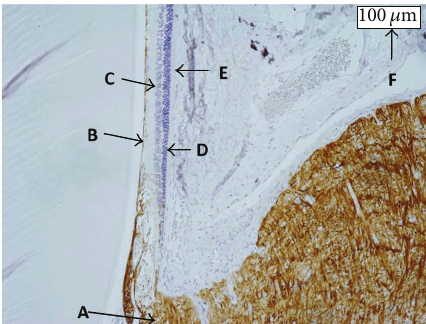
Figure 4: The retina in a normal SD rat older than 50 weeks. The brown region shows stained GFAP. A: optic nerve disc; B: ILM; C: INL; D: outer nuclear layer; E: retinal pigment epithelium; F: index of 100 𝜇 m. The area of stained GFAP is limited around the ILM and does not appear around the